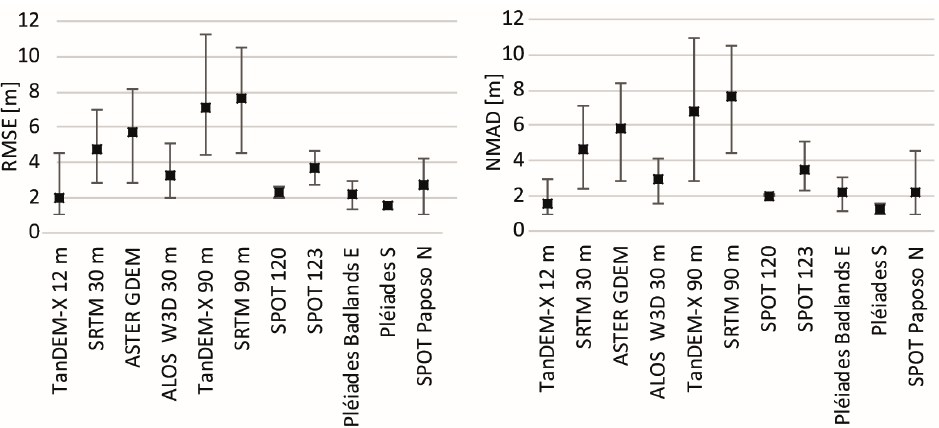
Figure 9. Distribution of calculated RMSE and NMAD of the individual UAV-derived reference datasets compared to elevation models.